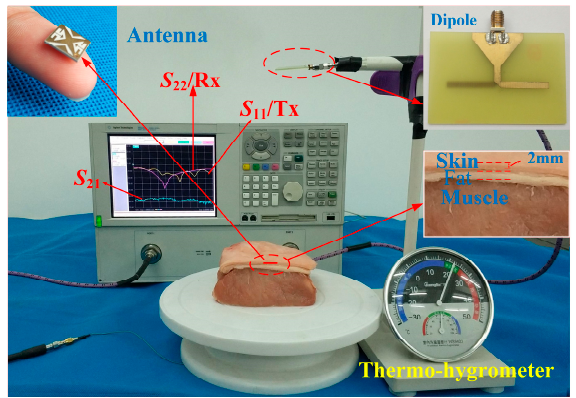
Figure 12. Photograph of the fabricated antenna prototype and measurement setup.